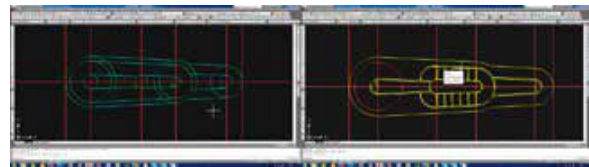
Figure 7. Modeling and rendering of urban and environmental context of 'Casa del Marinaretto'. Digital model by F. Carota.